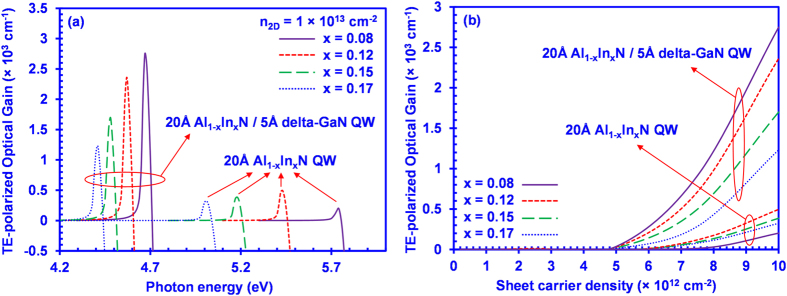
(a) TE-polarized optical gain spectra at n2D = 1 × 1013 cm−2, and (b) TE-polarized peak optical gain as a function of sheet carrier density for 20 Å Al1–xInxN/5 Å delta-GaN QW and for 20 Å Al1–xInxN QW.